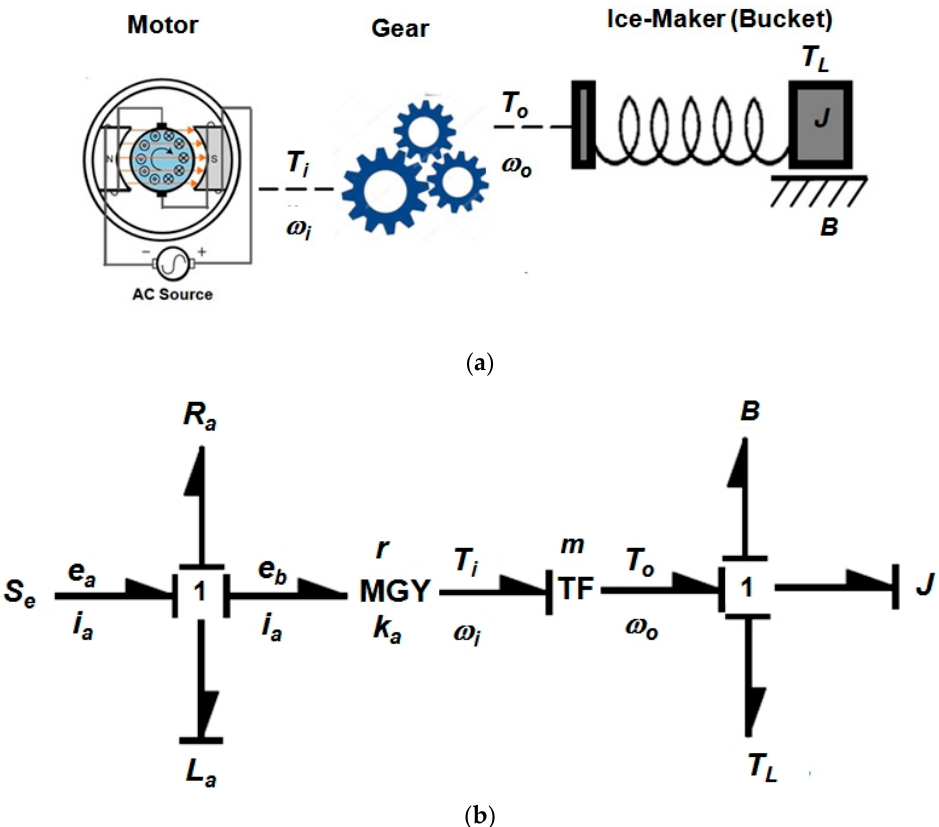
Figure 6. Design concept of an ice-maker. ( a ) Schematic diagram of auger motor and ice bucket assembly. ( b ) Bond graph modeling of auger motor and ice bucket assembly.